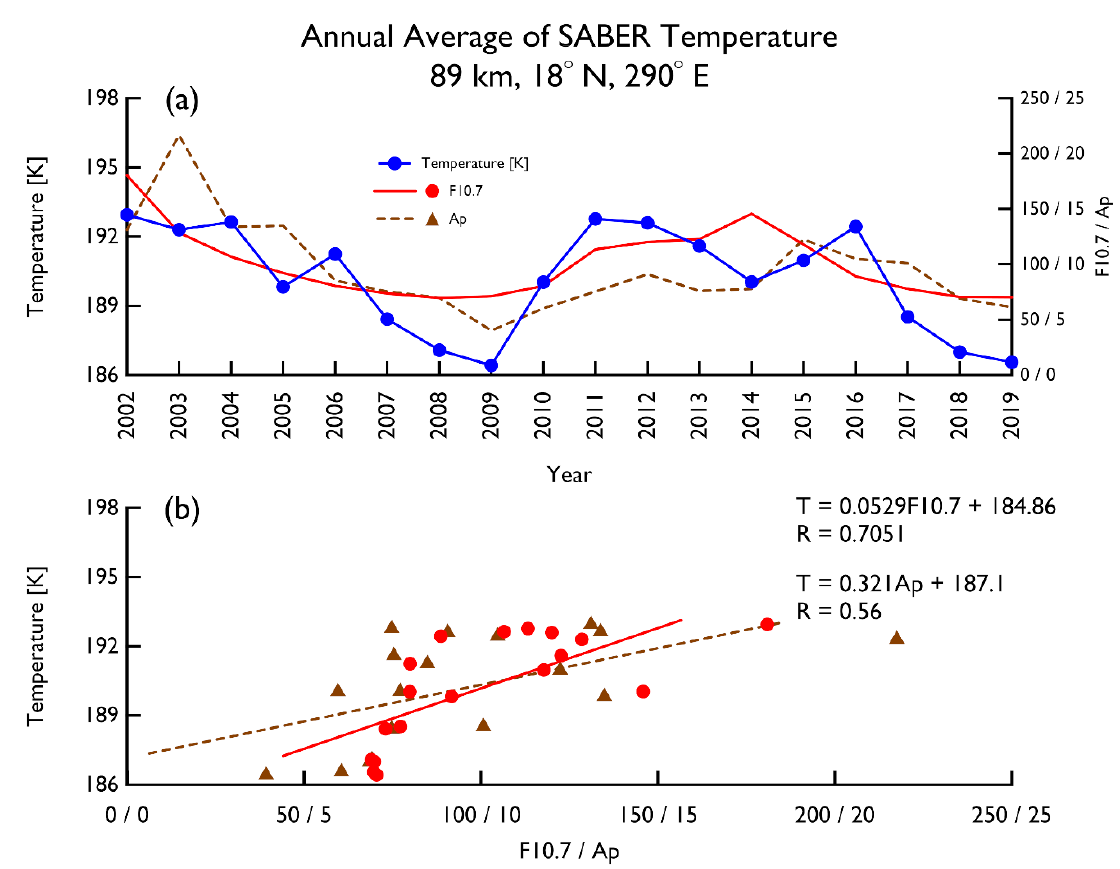
Figure 1. Annual average of SABER temperature at 18° N, 290° E at 89 km. ( a ) Time series of temperature (blue line with dots), F10.7 (red line), and Ap index (brown dashed line). ( b ) Trend analysis of temperature as a function of the F10.7 (red line and dots) and of the Ap index (brown dashed line and triangles).